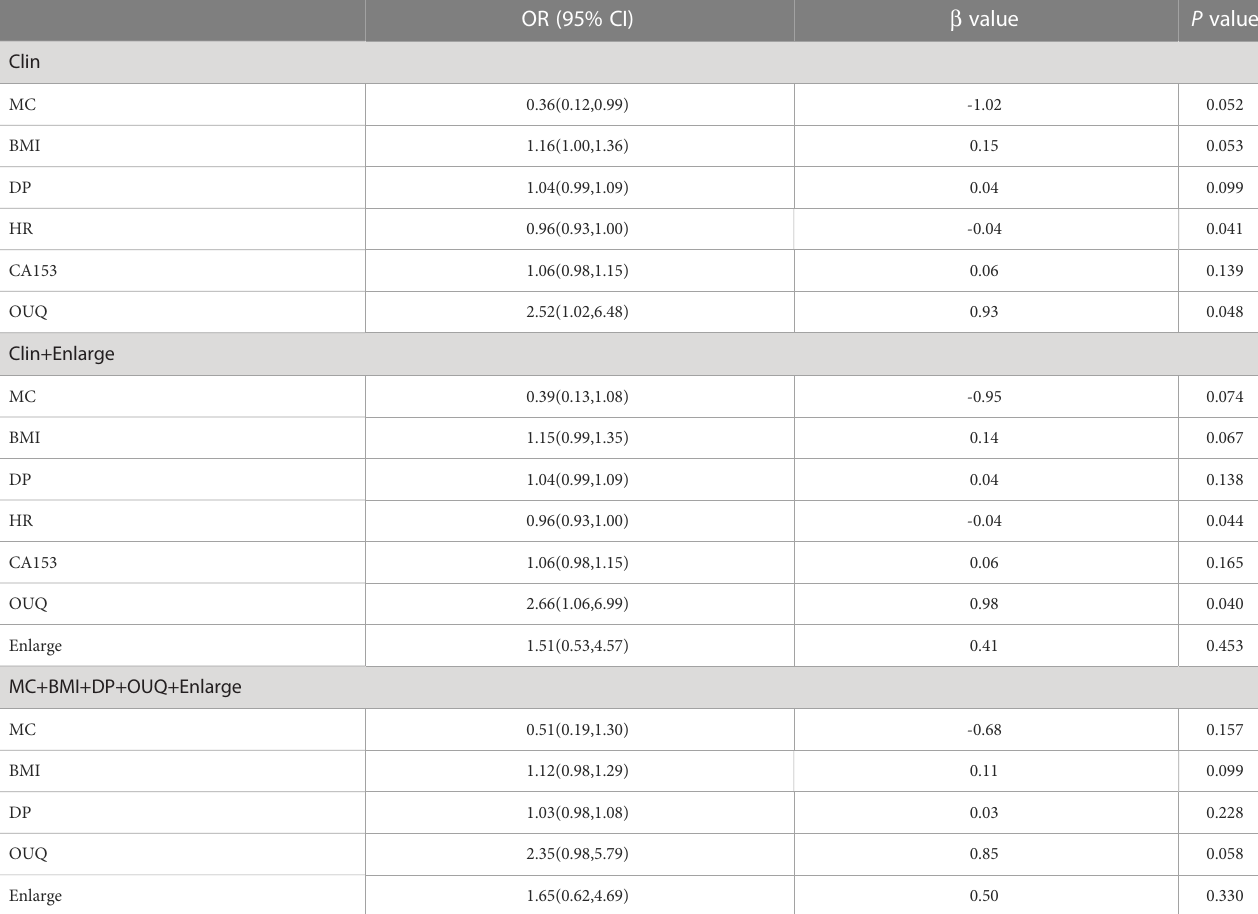
TABLE 2 Multivariate analysis of clinical and CEUS features for predicting Her-2 overexpressing in training cohort. OR (95% CI)